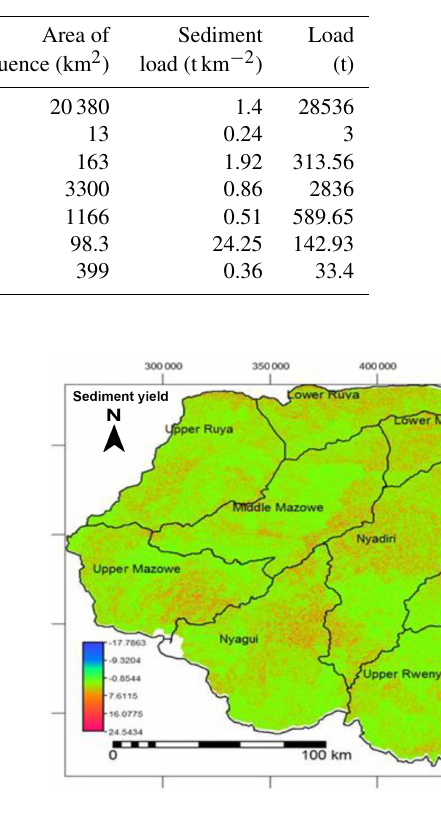
Figure 4. Sediment Yield within the Catchment. Table 5. Results for the correlation between sediment yield and wa- ter quality